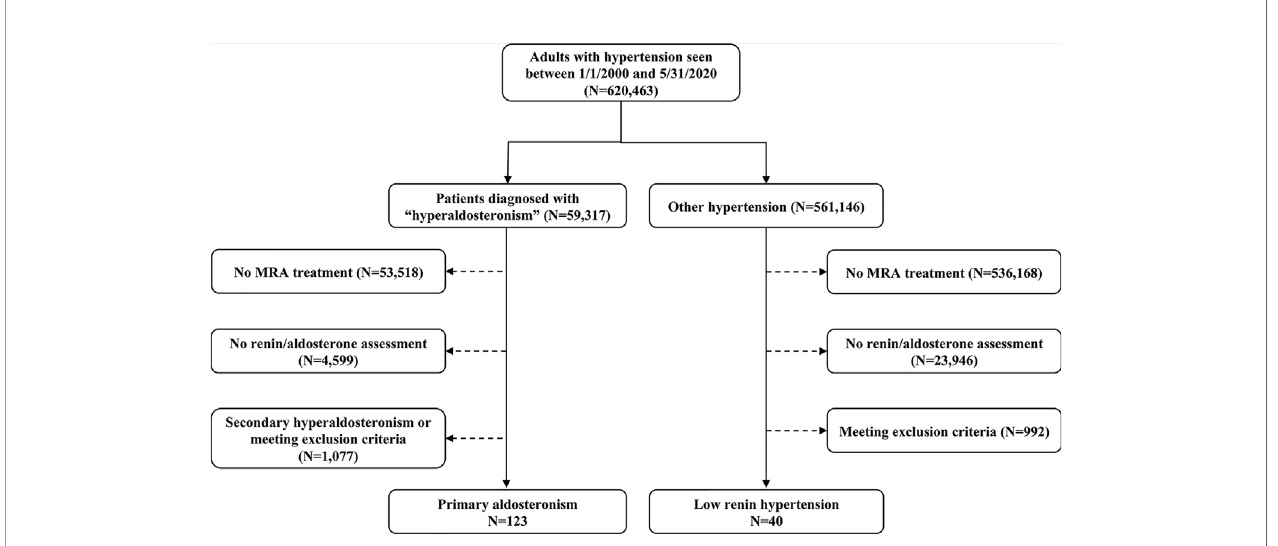
FIGURE 1 | Selection of study participants. MRA, mineralocorticoid receptor antagonist; PA, primary